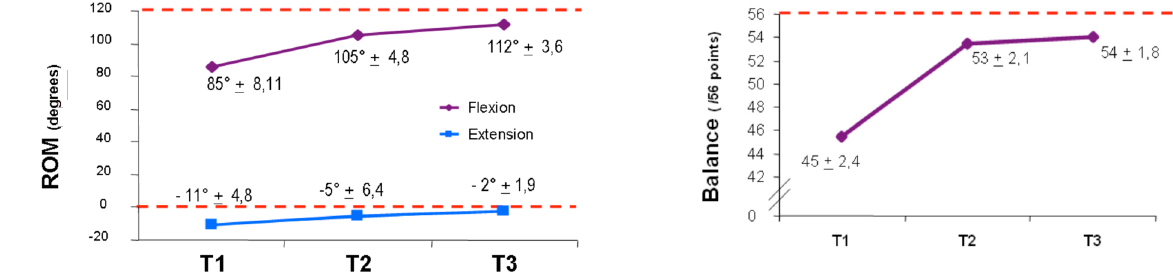
Figure 5. Berg Test Score